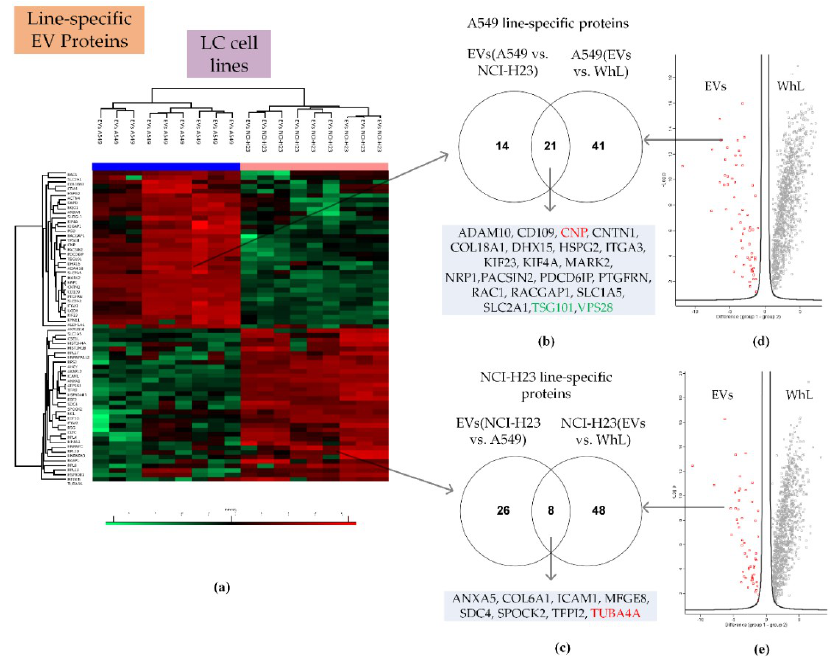
Figure 4. Proteomic search for LC line-specific EV proteins. ( a ) Heatmap that compares 69 proteins of EVs derived from the A549 and NCI-H23 cell lines (Figure S4 shows the heatmap in detail); ( b ) Venn diagram that shows the intersection of proteins that were more abundant in A549 line-derived EVs compared to NCI-H23 line-derived EVs and proteins that were more abundant in the EV fraction compared to the WhL of A549 cell line; ( c ) Venn diagram that shows the intersection of proteins that were more abundant in NCI-H23 line-derived EVs compared to A549 line-derived EVs and proteins that were more abundant in the EV fraction compared to the WhL of the NCI-H23 cell line; ( d ) volcano plot that shows the differences in protein abundance in the EV fraction (in red) and in the WhL (in black) for the A549 cell line. Overall, 1121 proteins identified by at least 4 unique peptides per protein were statistically significant (Student’s t -test, truncation: permutation-based FDR = 0.01, S0 = 2, Perseus 1.6.0.7 software (Max Planck Institute of Biochemistry, Martinsried, Germany). Figure S5 shows the volcano plot in detail; ( e ) the volcano plot that shows the differences in protein abundance in the EV fraction (in red) and in the WhL (in black) for the NCI-H23 cell line. Overall, 1173 proteins identified by at least 4 unique peptides per protein were statistically significant (Student’s t -test, truncation: permutation-based FDR = 0.01, S0 = 2, Perseus 1.6.0.7 software (Max Planck Institute of Biochemistry, Martinsried, Germany). Figure S6 shows the volcano plot in detail; for ( d , e ), normalized data of the LFQ intensities were used for visualization of the protein level. The LFQ intensities were log2 transformed. Differences in protein abundance (taking into account the log2 transformation) are plotted on the x-axis, while -Log p (log10 transformed p -value) is shown on the y-axis. Line-specific EV proteins that were also determined to be universal and tissue-specific markers are highlighted in red and green, respectively. Detailed data are presented in the Supplement 4.